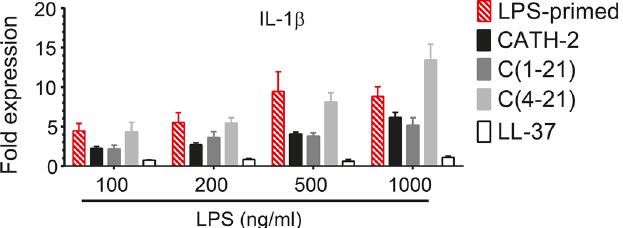
Fig 7. CATH-2 analogs partially neutralize IL-1 β transcription in LPS-primed cells. HD11 cells were primed for 30 min with S . minnesota LPS (100 – 1000 ng/ml), washed once and incubated during 4h in the presence or absence of 20 μ M peptide. IL-1 β transcription was measured by real time QPCR analysis. Data from 3 to 4 independent experiments (means ±